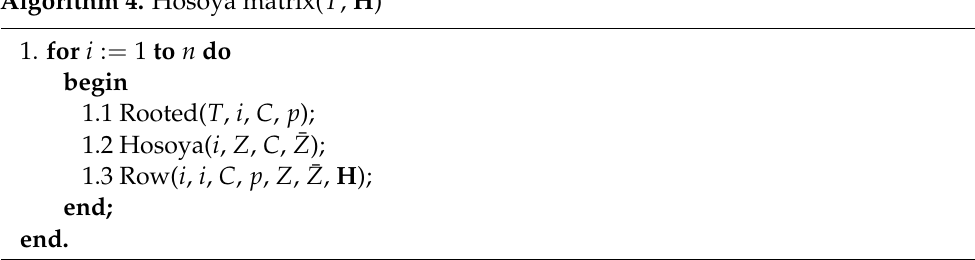
Algorithm 4. Hosoya matrix( T , H